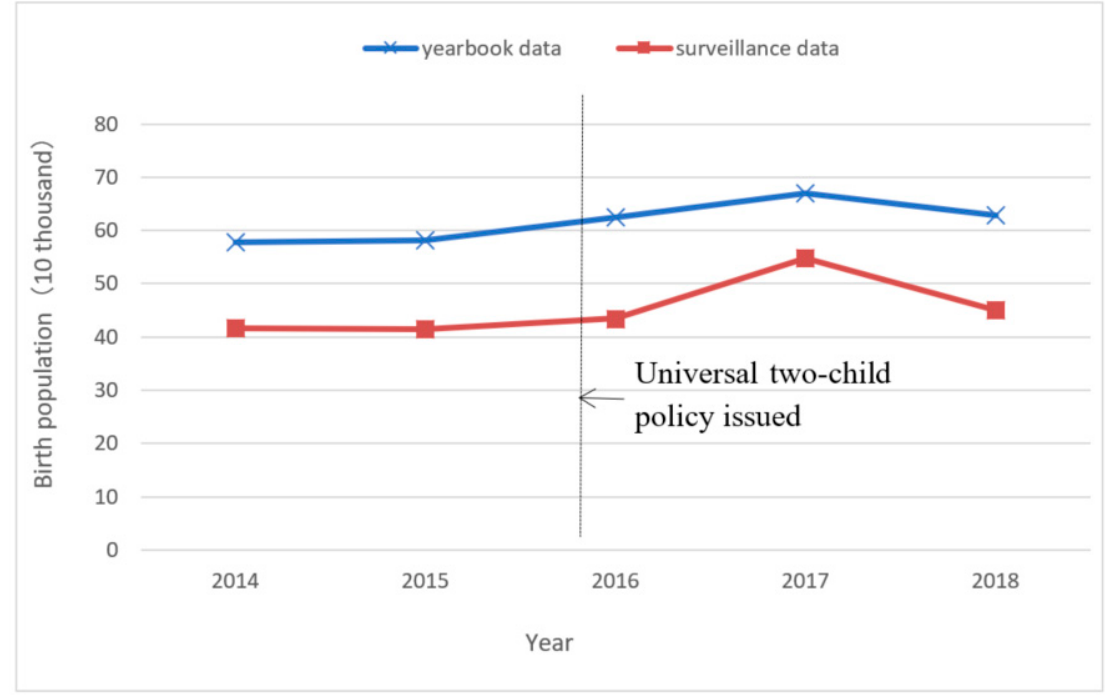
Figure 1. Comparison of the birth population data from different sources in Zhejiang Province, China, 2014–2018.